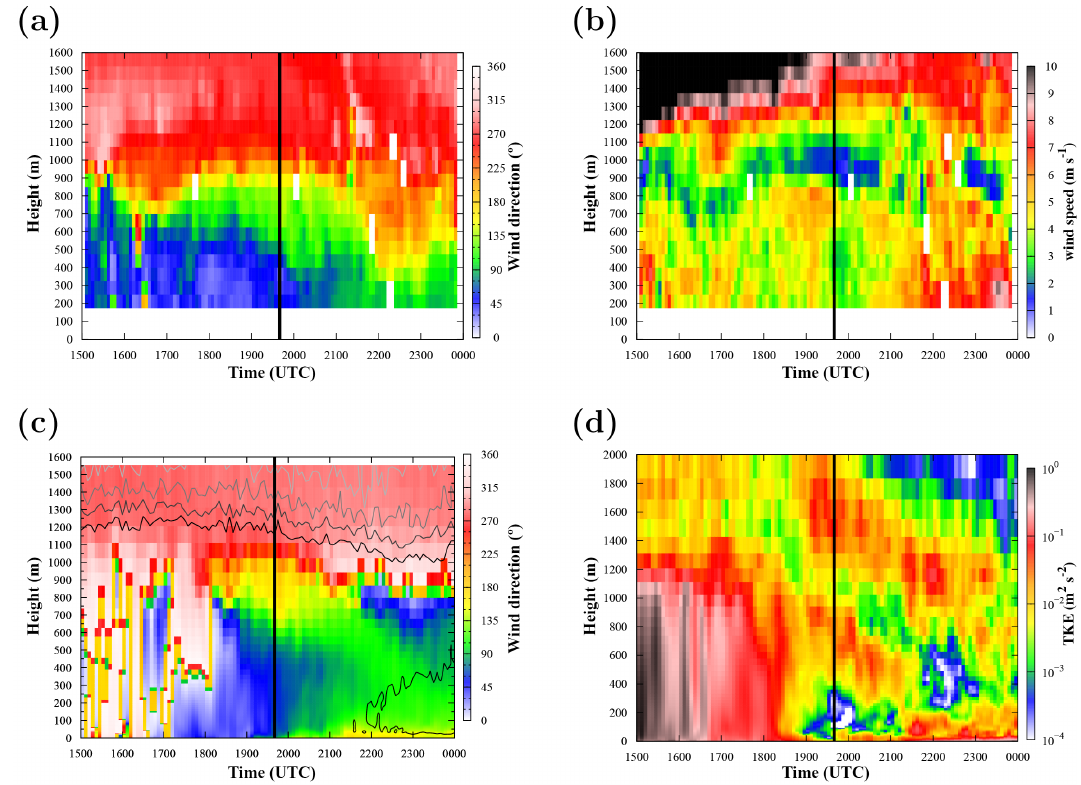
Figure 4. Temporal evolution of the vertical profiles for (a) UHF wind direction (in ◦ ), (b) UHF wind speed (in ms − 1 ), (c) MesoNH wind direction (in colours) and wind speed (in lines, for values ≥ 4ms − 1 , contour interval = 2ms − 1 ) and (d) MesoNH TKE (in m 2 s − 2 ). The time of sunset is represented by a black vertical